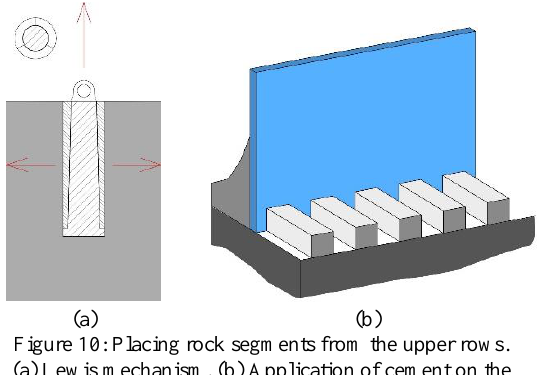
Figure 10: Placing rock segments from the upper rows. (a) Lewis mechanism, (b) Application of cement on the upper surface of the segment underneath using special aluminum